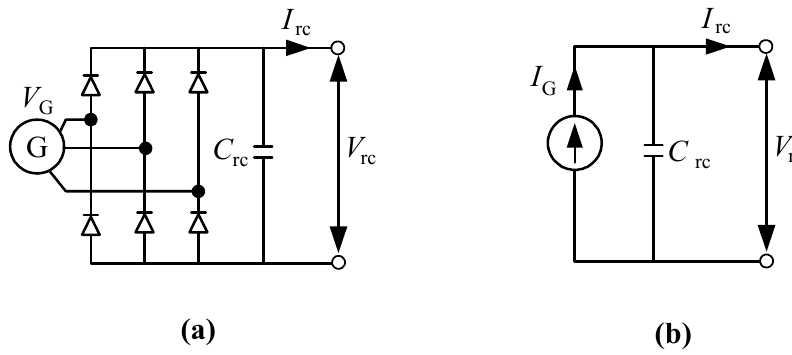
Figure 4. Simplified double ‐ stator generator and rectifier model. ( a ) Model of the double ‐ stator generator with a rectifier; ( b ) Simulation mode. I rc : load current; V rc : load voltage; C rc : load capacitance; V G : generator voltage; I G : generator current.